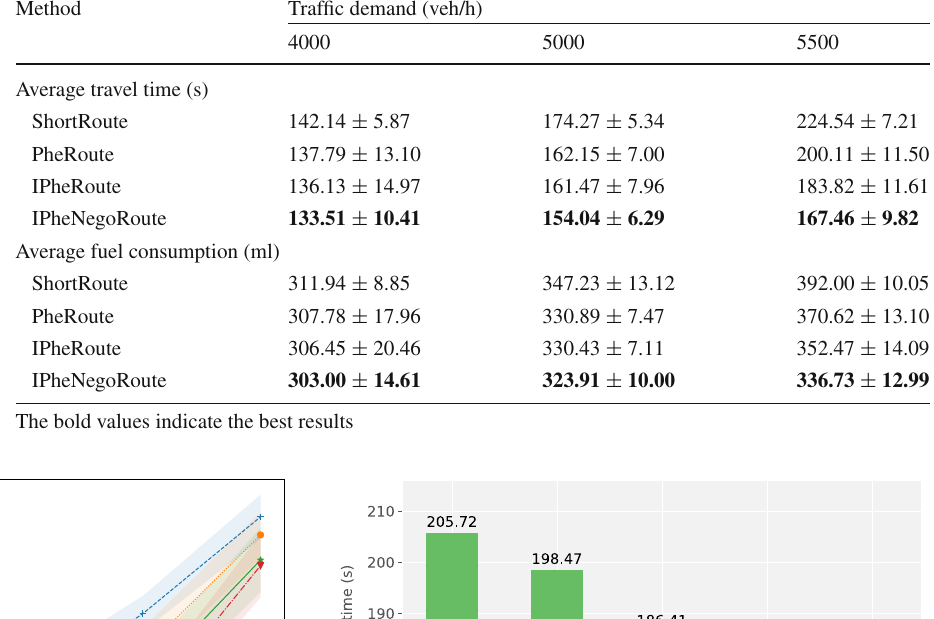
Table 3 Numerical results of traffic routing methods in the